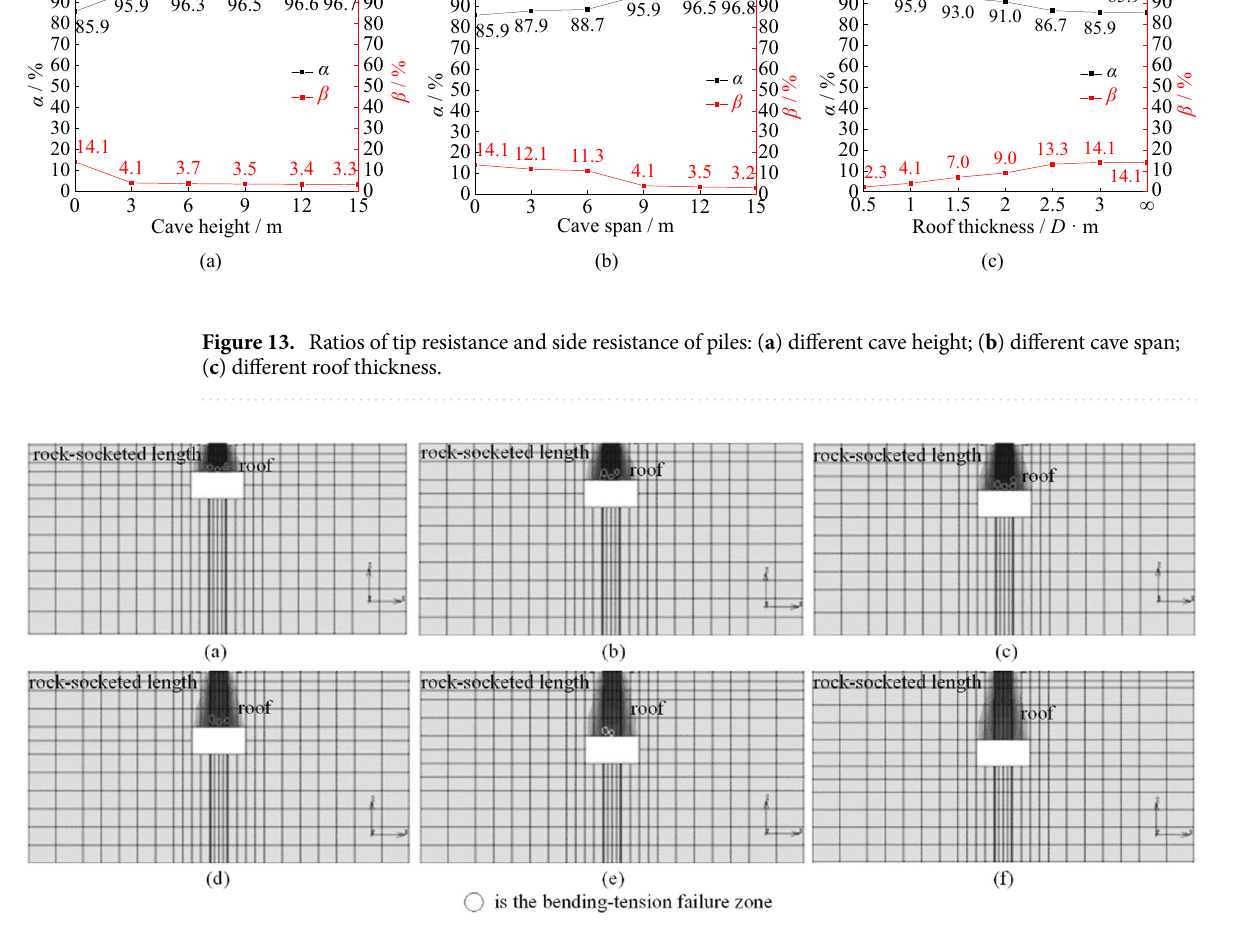
Figure 14. The failure of cave roof: ( a ) roof thickness = 0.75 m; ( b ) roof thickness = 1.5 m; ( c ) roof thickness = 2.25 m; ( d ) roof thickness = 3.0 m; ( e ) roof thickness = 3.75 m; ( f ) roof thickness = 4.5